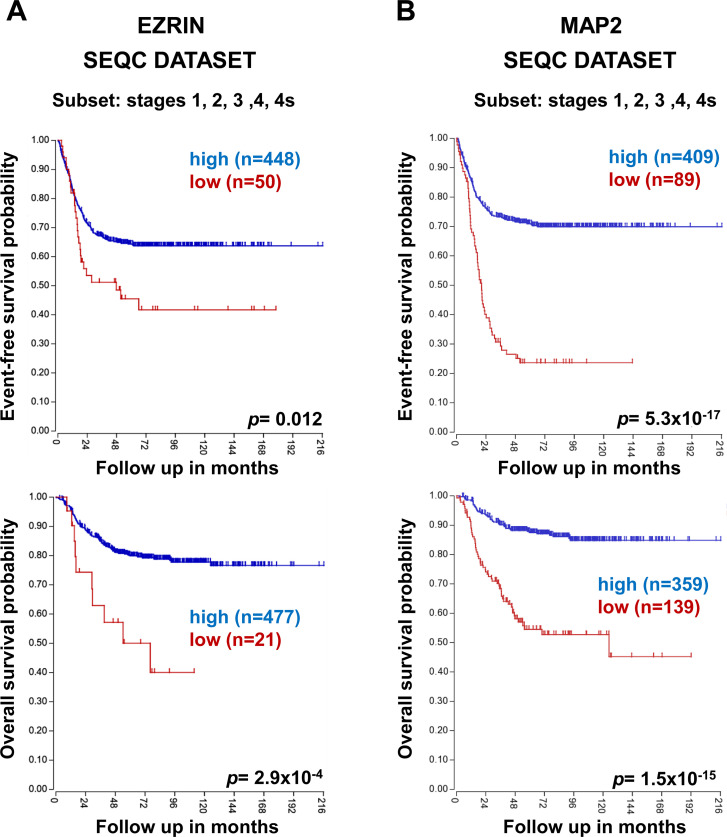
NB patients’ outcome based on EZRIN and MAP2 gene expression.Using the SEQC patients’ datasets in the R2 Genomics Analysis and Visualization Platform (http://r2.amc.nl), event-free survival (top) and overall survival (bottom) curves were generated for (A)
EZRIN and (B)
MAP2 (Microtubule-associated protein-2) expression in all NB stages patients. Patients’ numbers (n) are shown in parentheses.